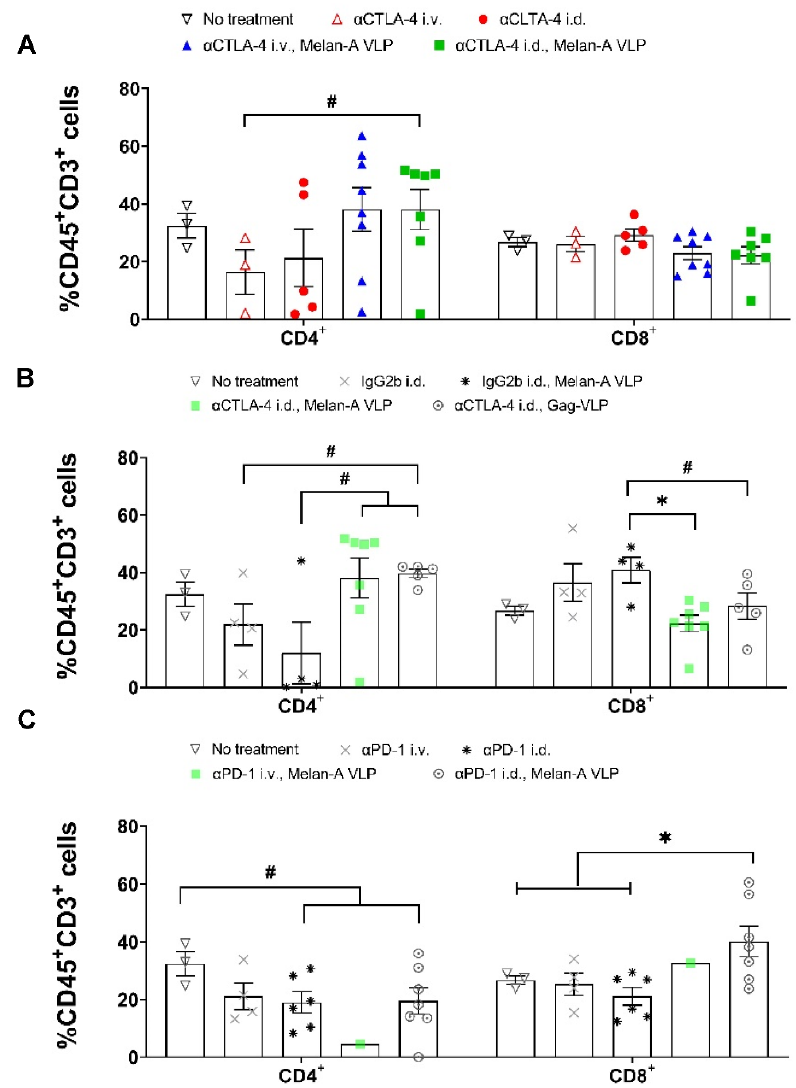
Figure 4. ( A ) Lymphatic delivery of α CTLA-4 monotherapy alone or in combination with Melan-A VLP significantly reduces tumor growth. Primary tumor volume versus d.p.i. for untreated animals ( ▽ , grey n = 5); and animals dosed with α CTLA-4 i.v. ( △ , red, n = 5); α CTLA-4 i.d. ( ● , red, n = 7); α CTLA-4 i.v., Melan-A VLP ( ▲ , blue, n = 10); and α CTLA-4 i.d., Melan-A VLP ( ■ , green n = 10). ( B ) Lymphatic delivery of α PD-1 monotherapy alone or in combination with Melan-A VLP significantly reduces tumor growth. Primary tumor volume versus d.p.i. for untreated animals ( ▽ , grey n = 5); and animals dosed with α PD-1 i.v. ( ■ , grey n = 4); α PD-1 i.d. ( ▼ , black, n = 9); α PD-1 i.v., Melan-A VLP ( ♦ , blue, n = 4); and α PD-1 i.d., Melan-A VLP ( ♦ green, n = 10). ( C ) Lymphatic delivery of Melan-A VLP alone significantly reduces tumor growth. Primary tumor volume versus days post implant for untreated animals ( ▽ , grey n = 5); and animals dosed with IgG2b i.d. (X, grey n = 4); IgG2b i.d., Melan-A VLP ( ✱ , grey, n = 4); α CTLA-4 i.d., Melan-A VLP ( ■ , green n = 10); and α CTLA-4 i.d., Gag-VLP ( ○ , grey n = 10). * Denotes first time point of statistical significance from unpaired, two-tailed Student’s t test ( p < 0.05). Error bars indicate SEM. i.v., intravenous; i.d., intradermal.